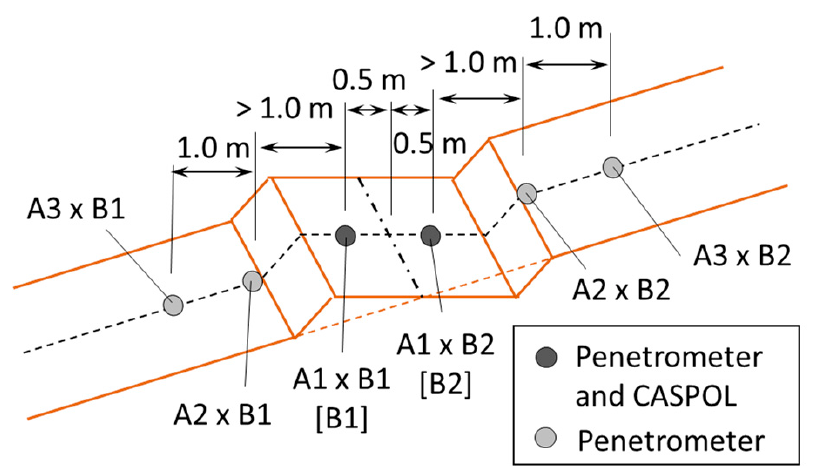
Figure 7. Measuring points on the spur road at each sample point of Site 2.